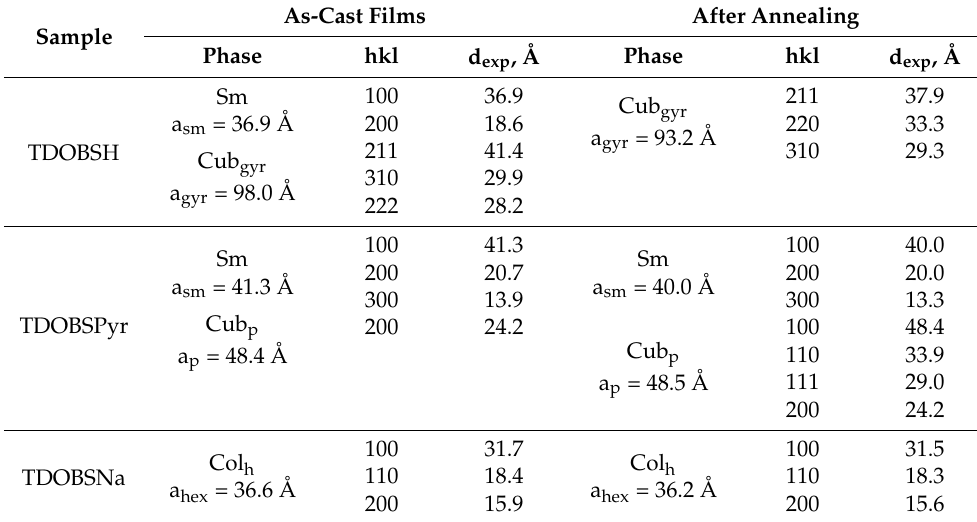
Table 2. Indexation of GIXD patterns of thin films.